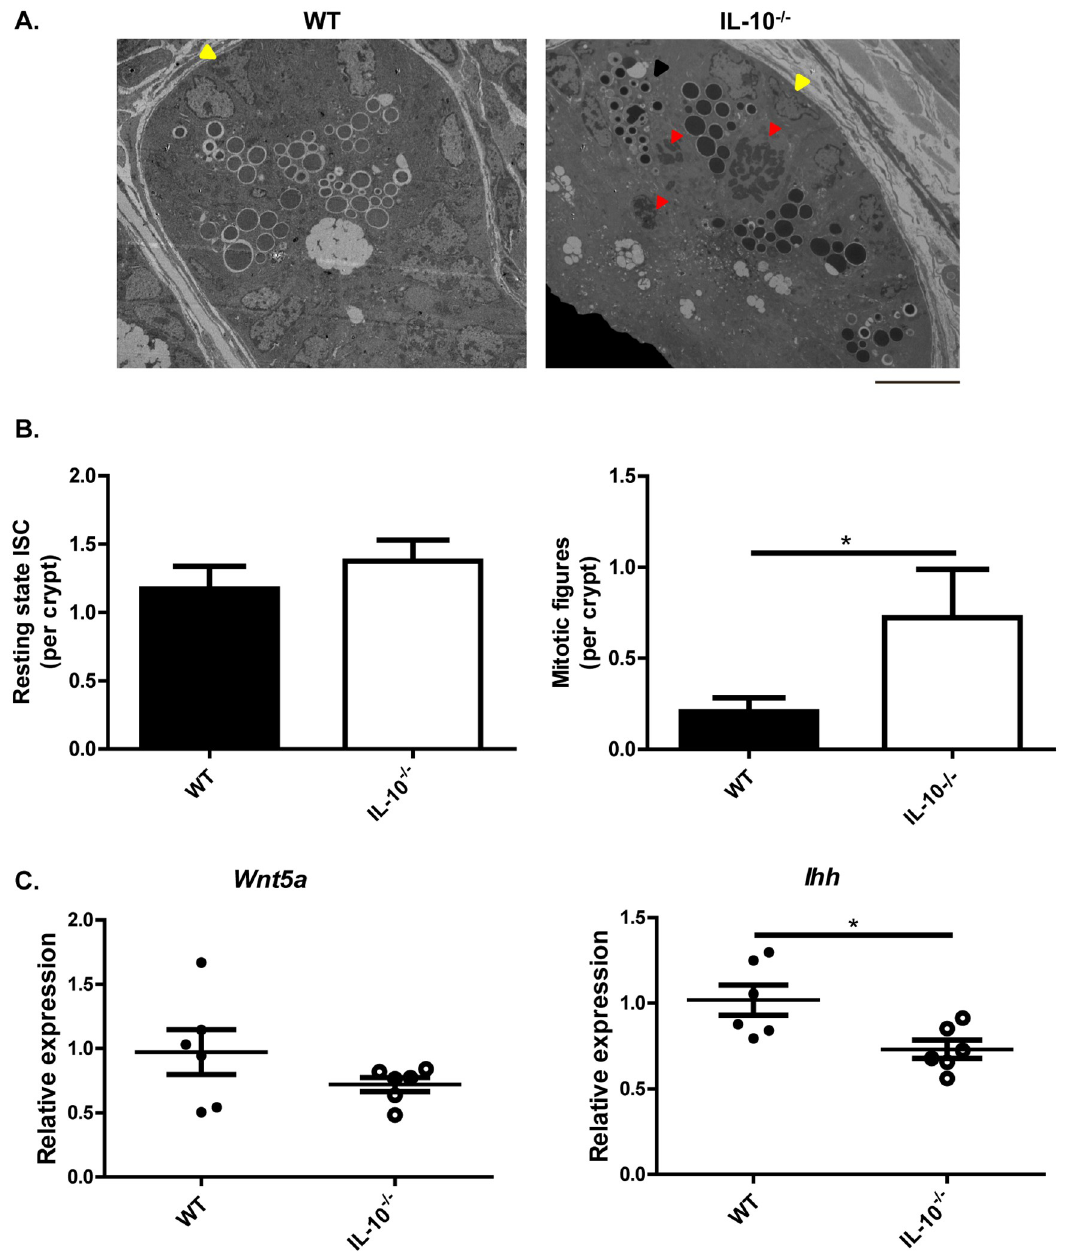
Fig 4. The crypts of IL-10 -/- mice have increased cell proliferation and alterations in secretory lineages allocation. (A) Ileum crypts of C57BL/6 and IL-10 -/- mice evaluated by transmission electron microscopy (scale bar is 10 μ m). In both strains were observed basal intestinal stem-cells (ISC) in resting state (yellow arrows) and undifferentiated cells in mitotic phase (red arrows). The black arrow shows a Paneth cell with intermediate granules located in the bottom of the crypt of an IL-10 -/- mouse. (B) Quantitative analysis of the number of basal ISC in resting state and undifferentiated cells in mitotic phase (red arrows) present in the crypts of C57BL/6 (n = 29 crypts) and IL-10 -/- (n = 20 crypts) mice (t-test � p<0.05). (C) Relative expression of Wnt5a and Ihh in ileum sections of WT (n = 5) and IL-10 -/- (n = 6) mice (U-test Mann Whitney � p<0.05).